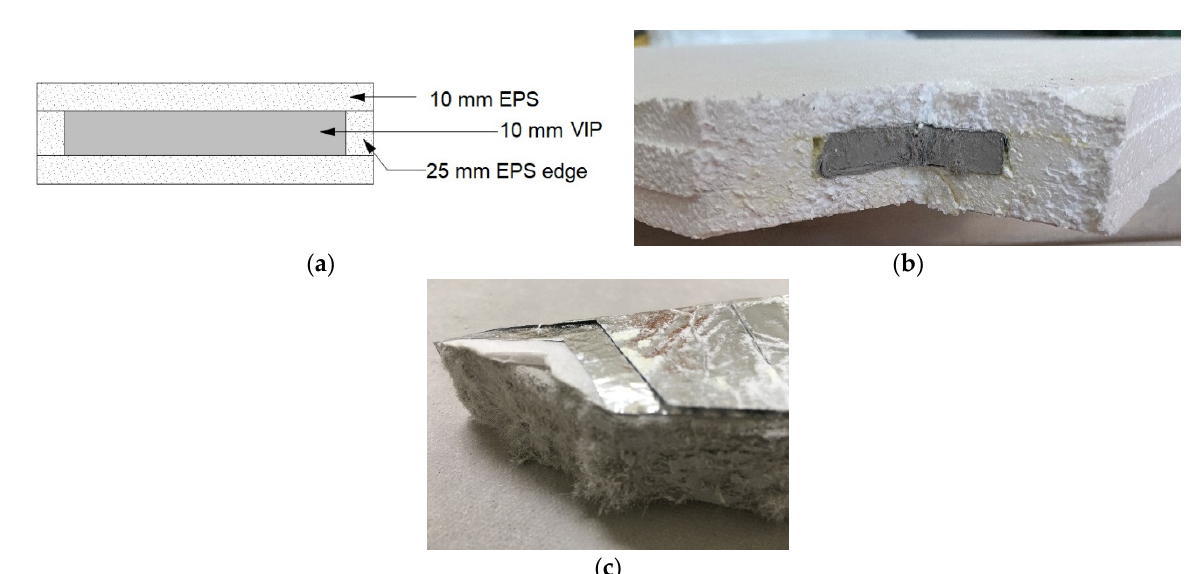
Figure 3. Tested encapsulated vacuum insulation Panel ( a ) sketch; ( b ) cross-section; ( c ) core material with the foil. Table 3. Thermal conductivity test results of the vacuum panel. Measurement Row